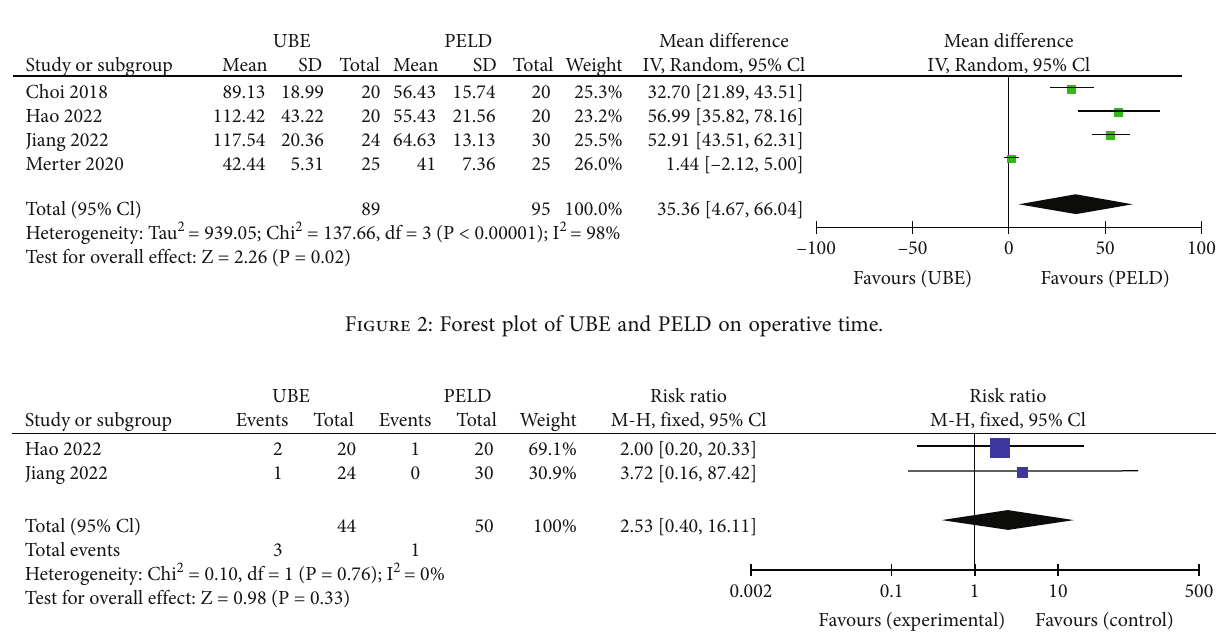
Figure 3: Forest plot of UBE and PELD on